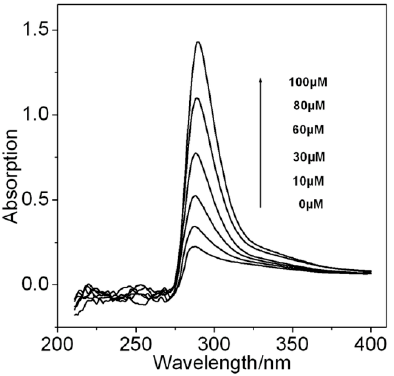
Figure 1. Evolution of UV spectra with increasing different amounts of paraoxon into 10 µ M ATP